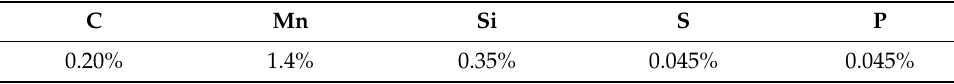
Table 1. Compositions of Q235